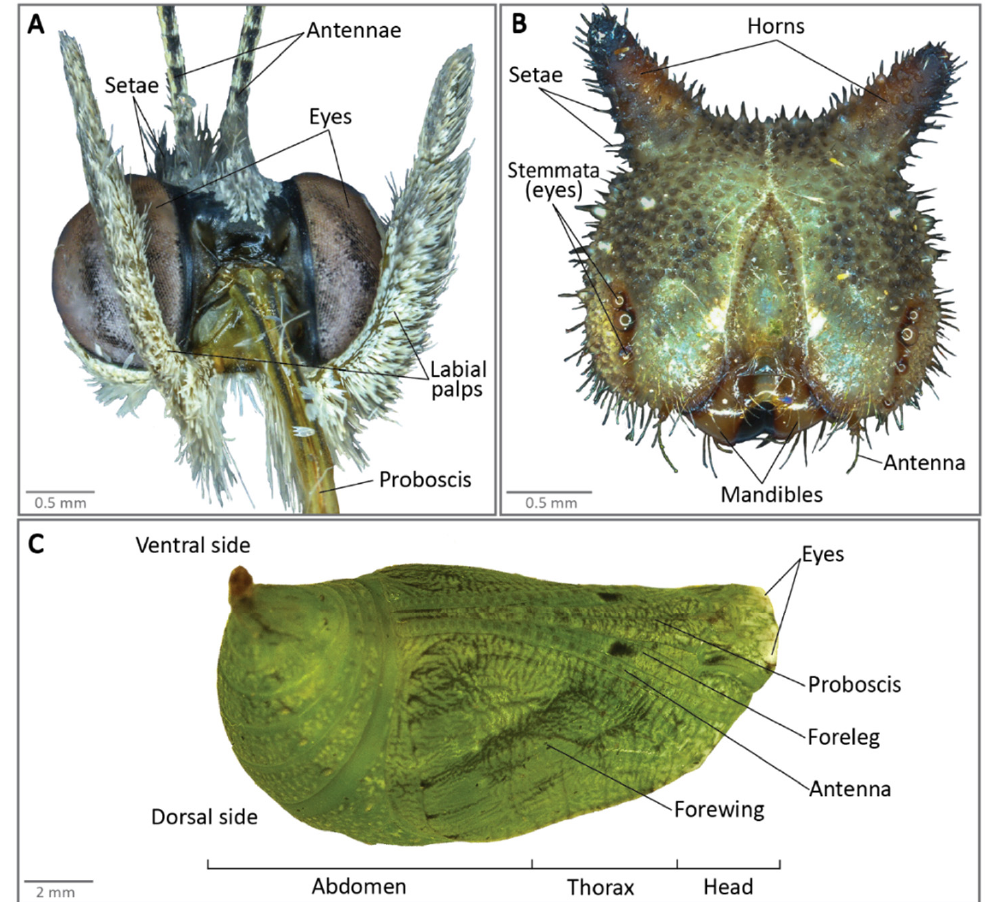
Figure 2. Anatomy of ( A ) a B. anynana butterfly head (front view), ( B ) a caterpillar head (front view), and ( C ) of a pupa.